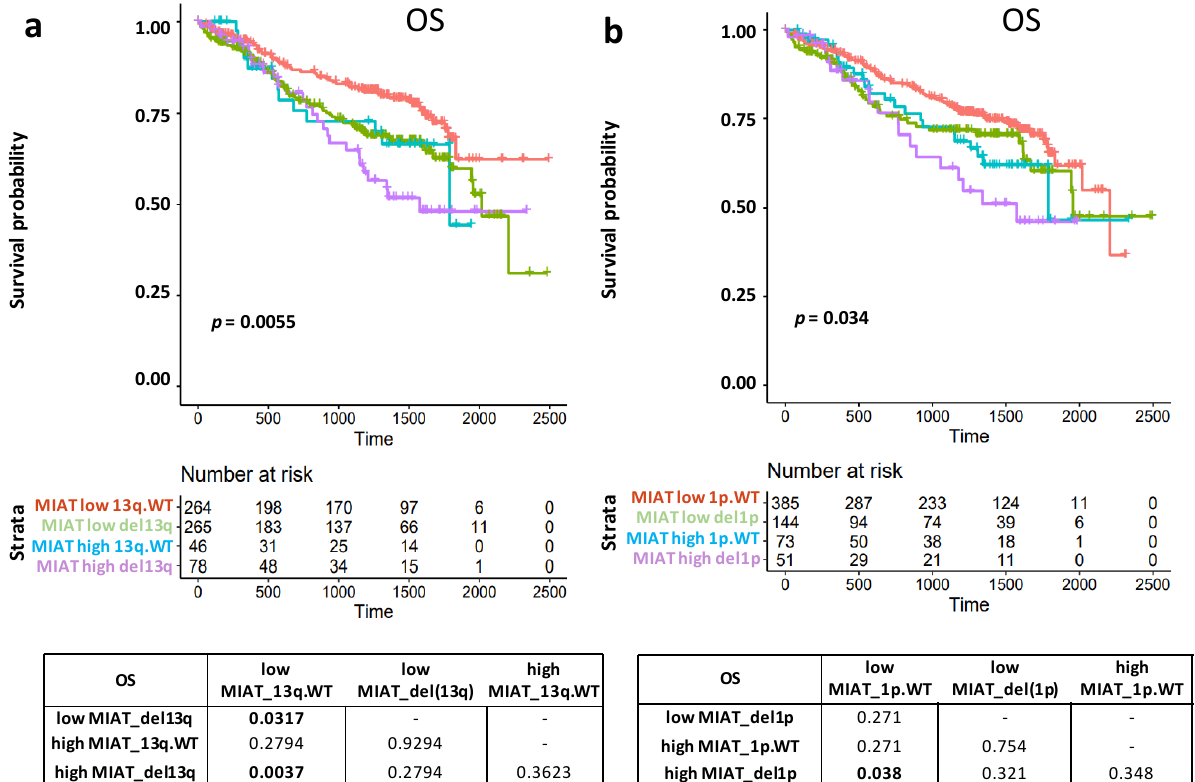
Figure 3. ( a , b ) Kaplan–Meier survival curves in 653 MM with expression, molecular and clinical data available. Log-rank test p -values measuring the global difference between survival curves and the number of samples at risk in each group across time are reported. Log-rank test p -values of pairwise comparisons are also reported; significant adjusted p -values by BH correction (<0.05) are in bold.